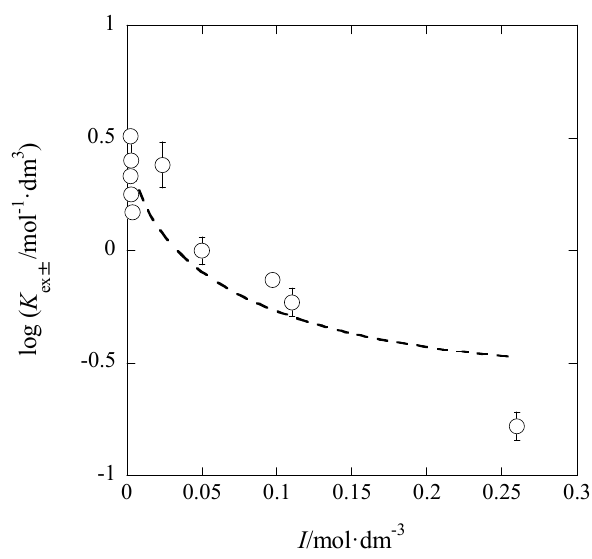
√ (cid:16) (cid:17) (cid:111) (cid:110) √ − 0.3 I I / I 1 + at